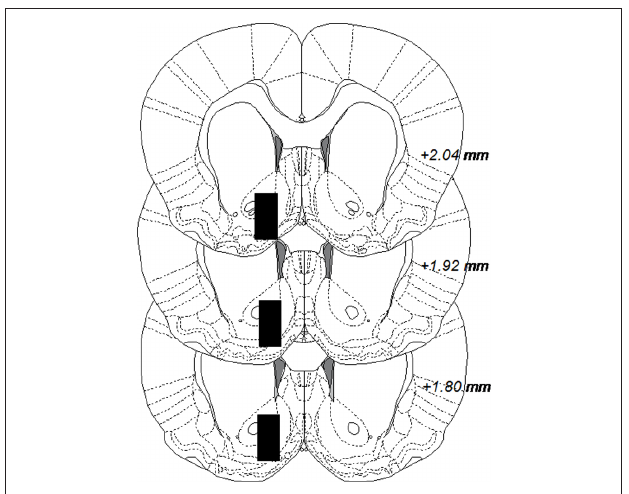
FiGure 1 | Coronal rat brain sections displaying black boxes which represent accepted areas for probe placements in nucleus accumbens. The number in each section indicates millimeters anterior from bregma. The figure is adapted from Paxinos and Watson